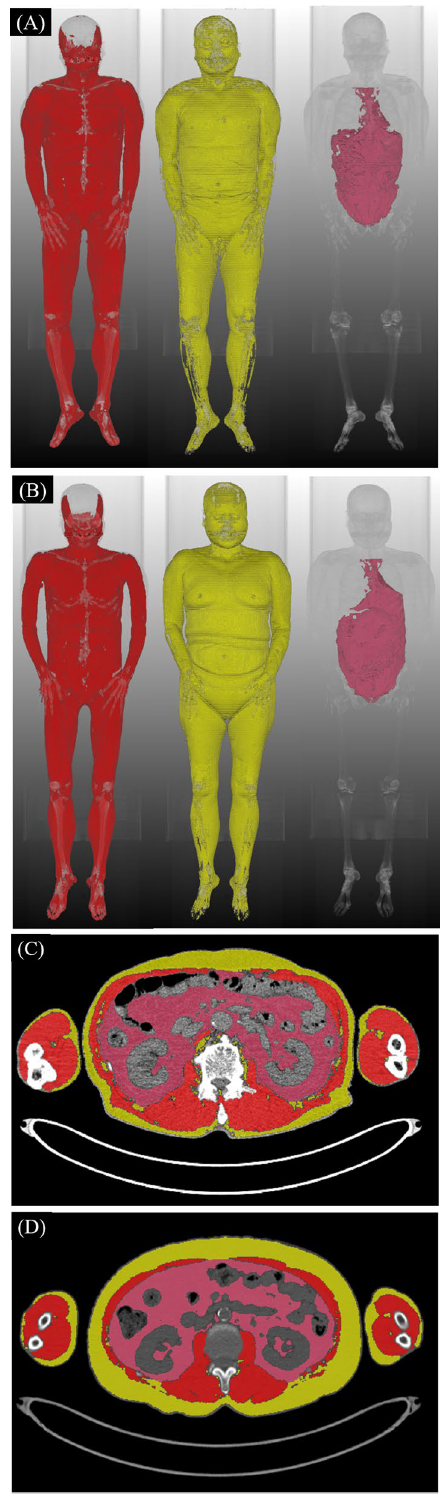
Fig. 2 Representative whole‑body 3D and cross‑sectional CT images of segmented body composition in a 77‑year‑old male ( A , C ) and a 68‑year‑old female ( B , D ) patients. Whole‑body 3D ( A , B ) and cross‑sectional images at the L3 level ( C , D ) show differences in the distribution of muscle (purple), subcutaneous fat (yellow), and intraabdominal fat (red) by sex. Thoracolumbar cross‑sectional areas of muscle, subcutaneous, and visceral fat were assessed from the trunk after excluding those tissues in the